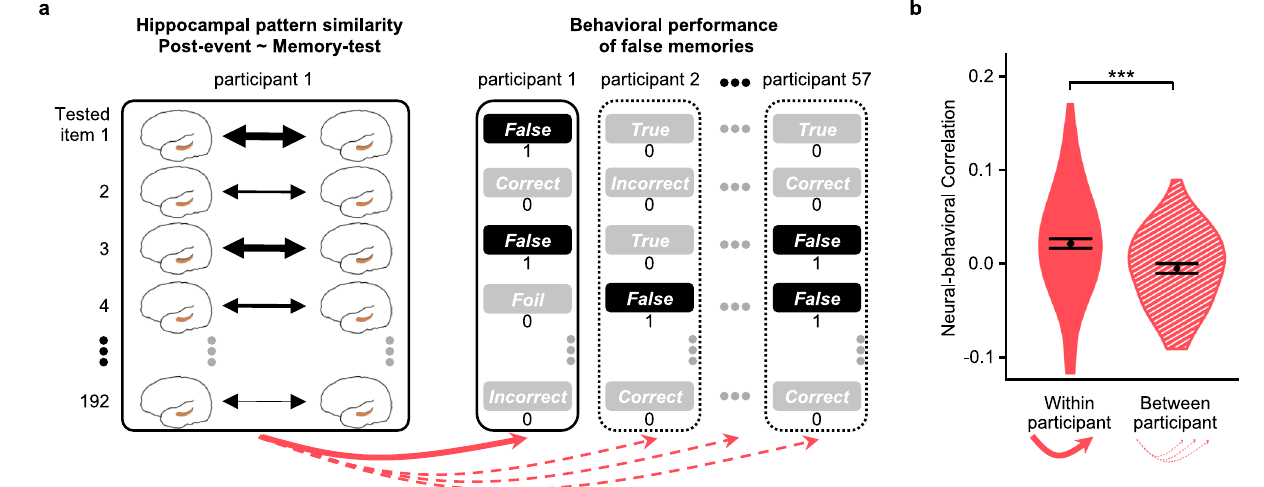
Fig. 4 | Hippocampus carries participant-speci fi c post-event information that predicts false memory. a Schematic representation of the individuation analysis forthecorrelationbetweenthehippocampalitem-speci fi crepresentationsofpost- eventinformationandthebehavioralpatternoffalsememoriesinthememorytest. We compared the within-participant neural-behavioral correlations (red solid arrow) to the between-participant neural-behavioral correlations (red dashed arrows). b The neural-behavioral correlations for false memory are shown for the